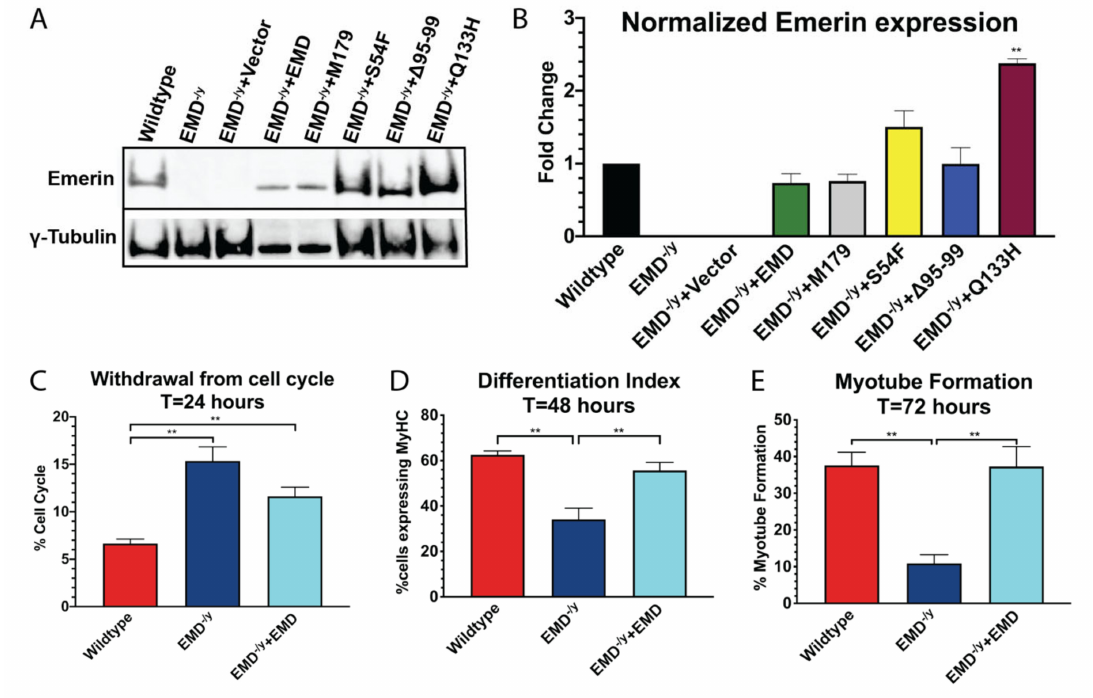
Figure 1. Transduction with emerin rescues di ff erentiation in EMD − / y myogenic progenitors. ( A ) Antibodies against emerin and γ -tubulin confirmed successful expression of lentiviral targets; ( B ) Densitometry was performed, and emerin protein levels in each cell line were normalized to γ -tubulin. Levels of emerin in each cell line was then normalized to wildtype cell line. ( C ) Wildtype (red), EMD − / y (dark blue) and + EMD (cyan) myogenic progenitors were induced to di ff erentiate by serum withdrawal, and withdrawal from cell cycle was monitored at 24 h by measuring the incorporation of EdU; ( D ) The di ff erentiation index was assessed at 48 h by determining the percentage of cells expressing MyHC; ( E ) Myotube formation was determined at 72 h by measuring the percentage of myotubes containing at least 3 nuclei and expressing MyHC; * p < 0.05, ** p <